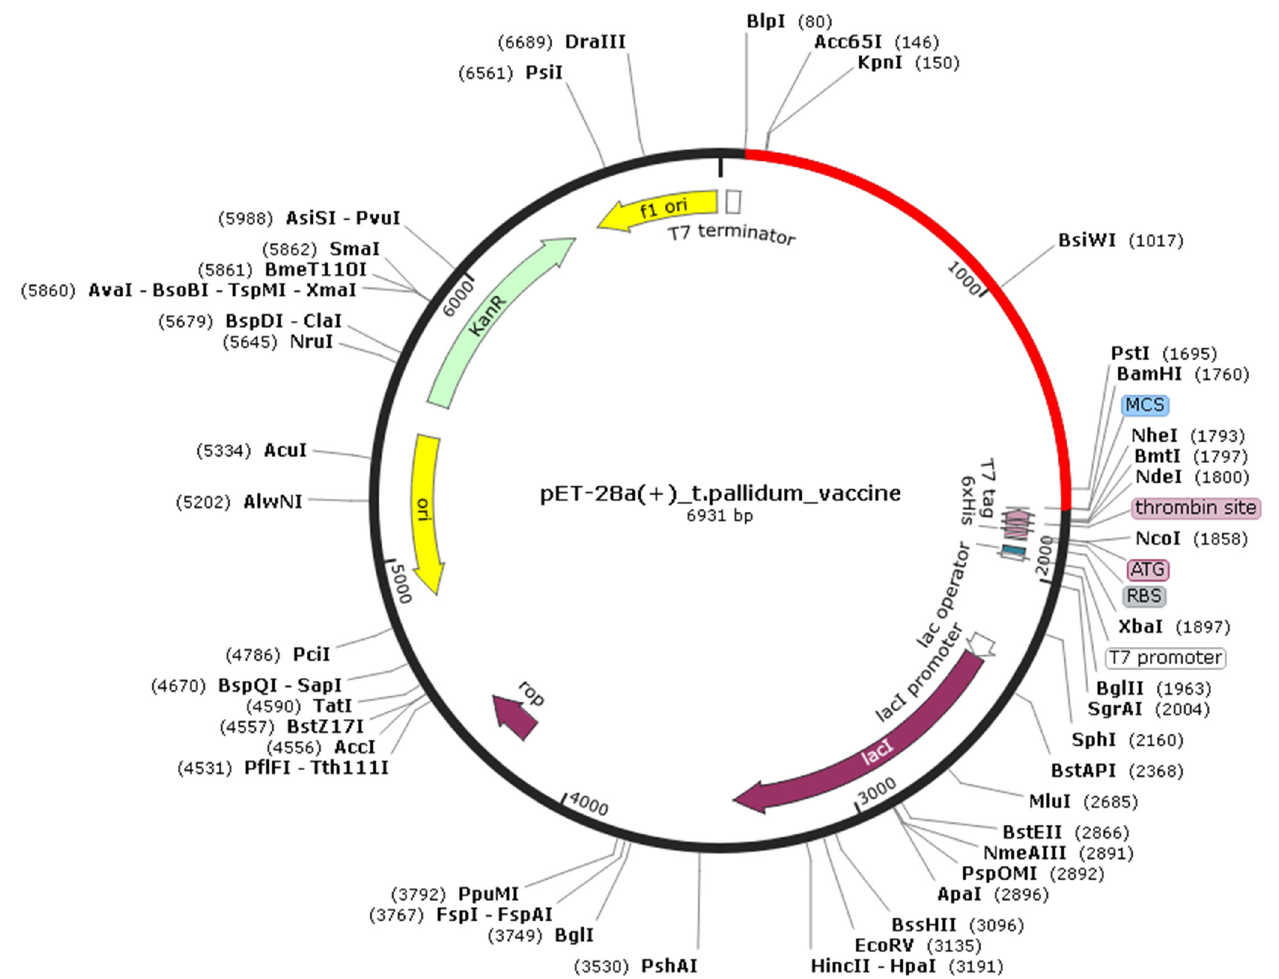
Figure 4. In silico cloning. Reverse translated sequence of the Tpme-VAC/LGCM-2022 protein insert represented in red between the BlpI and BamHI restriction sites. Vector is represented in black.